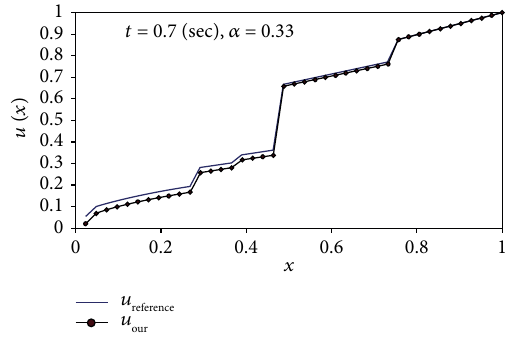
Figure 11: Variation of u ð x , t Þ versus x , with α = 0 : 33 , t = 0 : 7 sec .